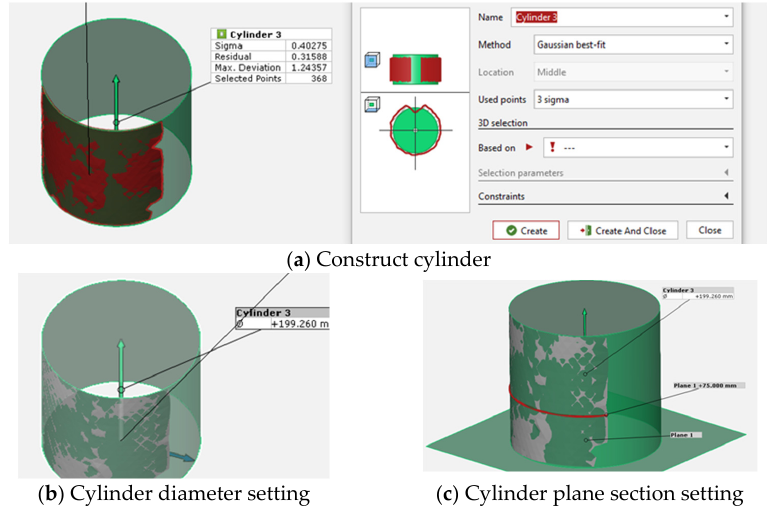
Figure 8. Construction of the fitting cylinder (lead block).